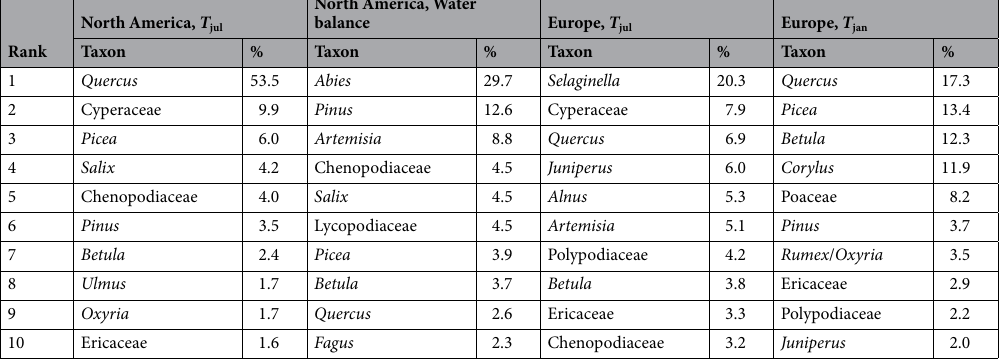
Table 4. Relative contribution of the ten most important predictor taxa for the boosted regression tree pollen– climate models for July mean temperature ( T jul ), January mean temperature ( T jan ), and water